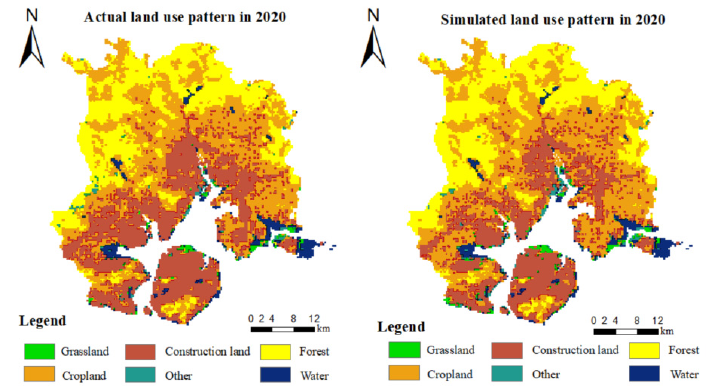
Figure 2. Actual and simulated land use map for the year of 2020.